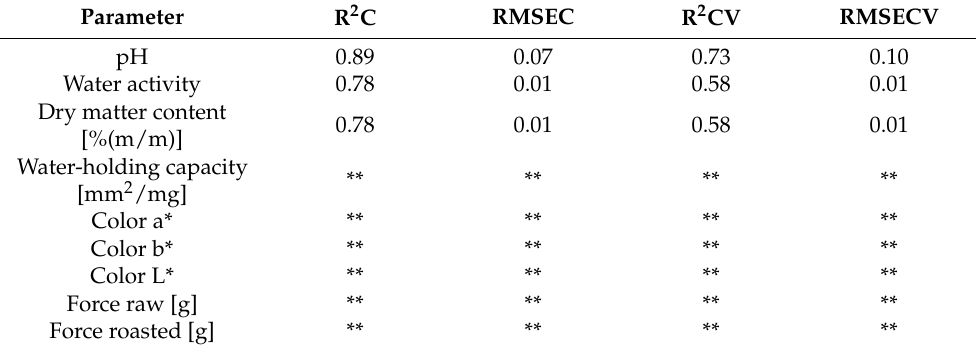
Table 2. PLSR prediction of physico-chemical parameters in domestic buffalo, Holstein, Hungarian Spotted, and Hungarian Grey bovine